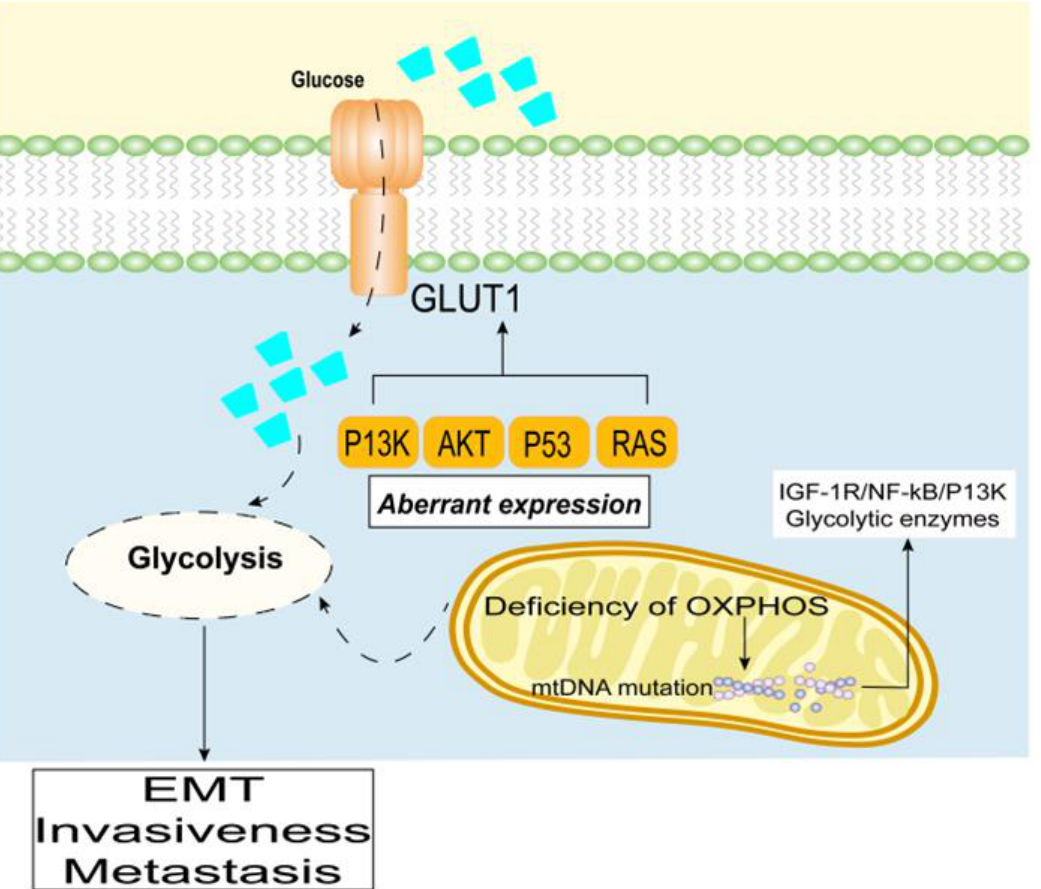
Figure 2. Promotion of PDAC through a high glycolytic phenotype.